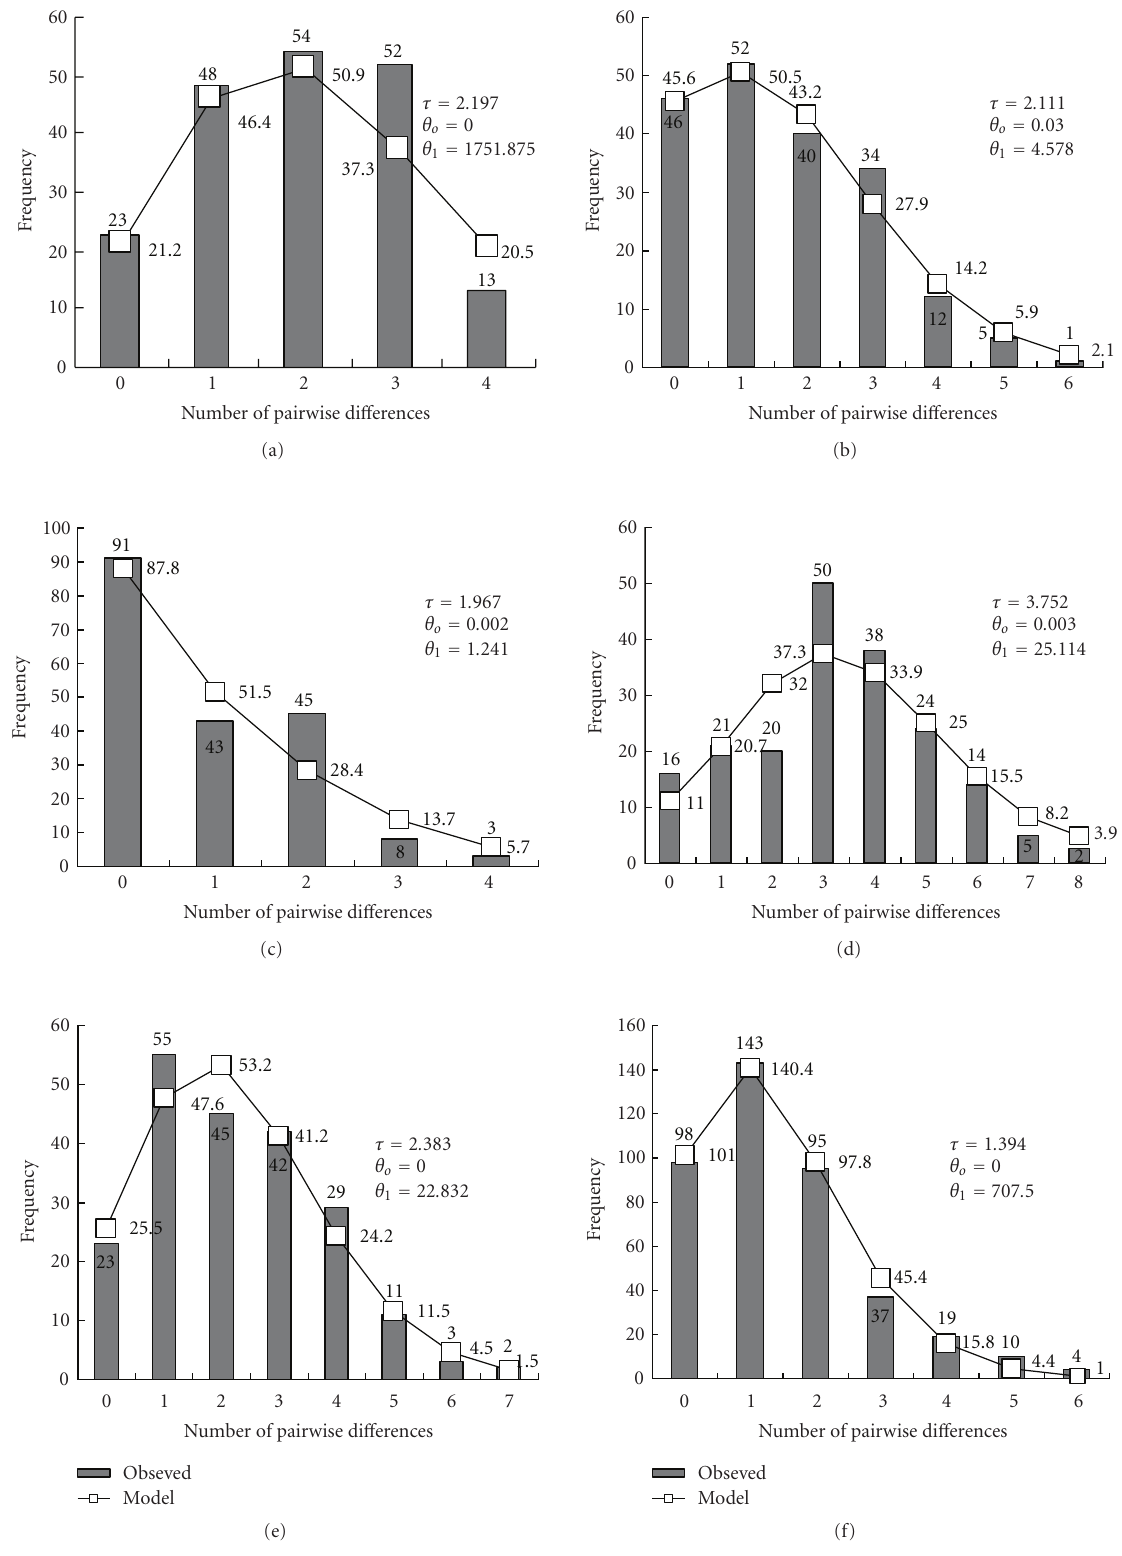
Figure 5: Mismatch distribution based on the 423-bp mitochondrial ND4 sequences. (a) B. japonicus from the Sagami Bay; B. platifrons from the Sagami Bay; B. platifrons from the Okinawa Trough; (d) B. marisindicus from the Kairei field; (e) B. septemdierum from the Myojin Knoll and the Suiyo Seamount; (f) B. brevior from the North Fuji